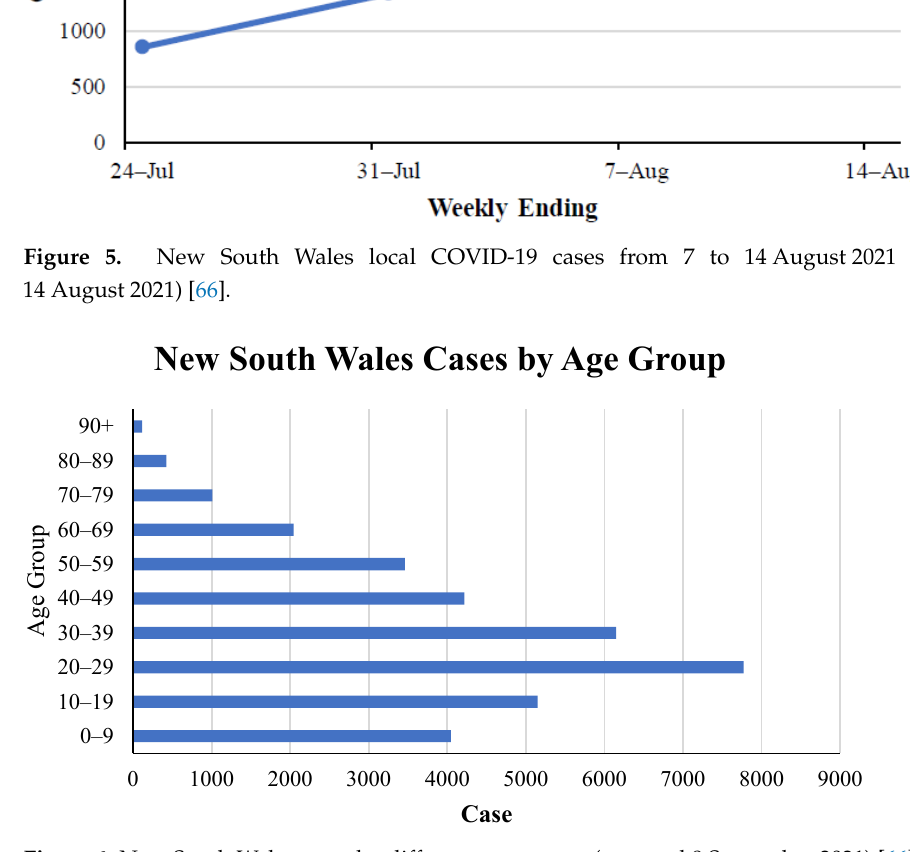
Figure 6. New South Wales cases by different age groups (accessed 8 September 2021) [66].